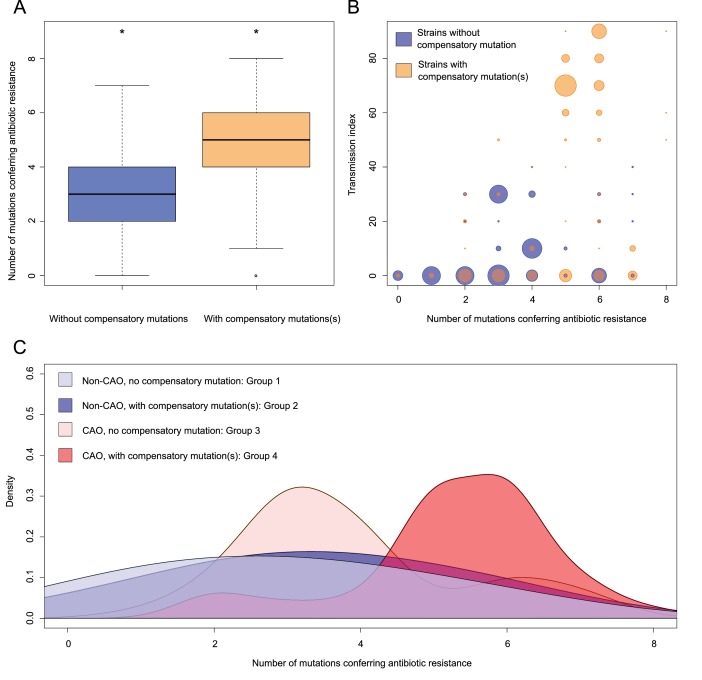
Compensatory mutations and drug resistance levels.Comparisons between isolates carrying compensatory mutations (in orange) and isolates with no-compensatory mutations (in blue), from the Karakalpakstan dataset. (A) Boxplot showing number of resistance mutations for the two categories (without or with compensatory mutations). The two categories were significantly different (two-sample t-test p=1.2×10−10). (B) Bubble plots showing the transmission index (number of isolates differing by less than 10 SNPs) as a function of antibiotic resistance related mutations. Bubble sizes are proportional to the number of isolates. (C) Density plot of the number of resistance-conferring mutations for four groups of isolates sourced from the Karakalpakstan data. Proportions are adjusted by using Gaussian smoothing kernels. The four groups are composed of non-CAO isolates with no compensatory mutations; non-CAO isolates carrying compensatory mutations; CAO isolates with no compensatory mutations and CAO isolates carrying compensatory mutations. These groups are respectively colored in light blue, dark blue, light orange and light red.